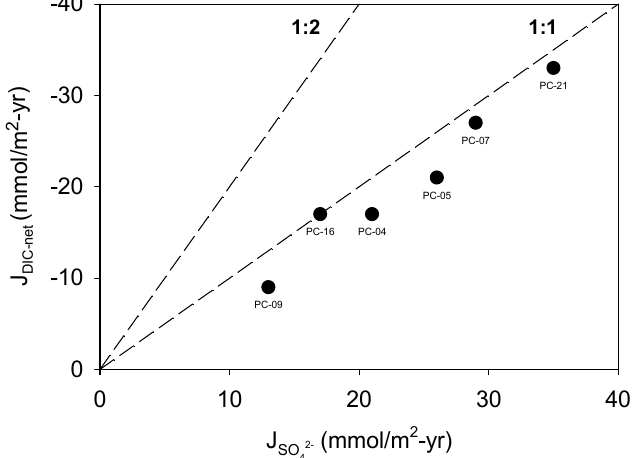
Figure 7. Scatter plot of (cid:1836) vs. J DIC-net for the AC-07 piston cores (Table 2). The 1:2 line (cid:2903)(cid:2899) (cid:3120)(cid:3118)(cid:3127) indicates the molar stoichiometry of SO 42 − consumption to DIC production for organoclastic SR (Equation (1)) and the 1:1 line indicates the molar stoichiometry of SO 42 − consumption to dissolved inorganic carbon production for anaerobic oxidation of methane (Equation